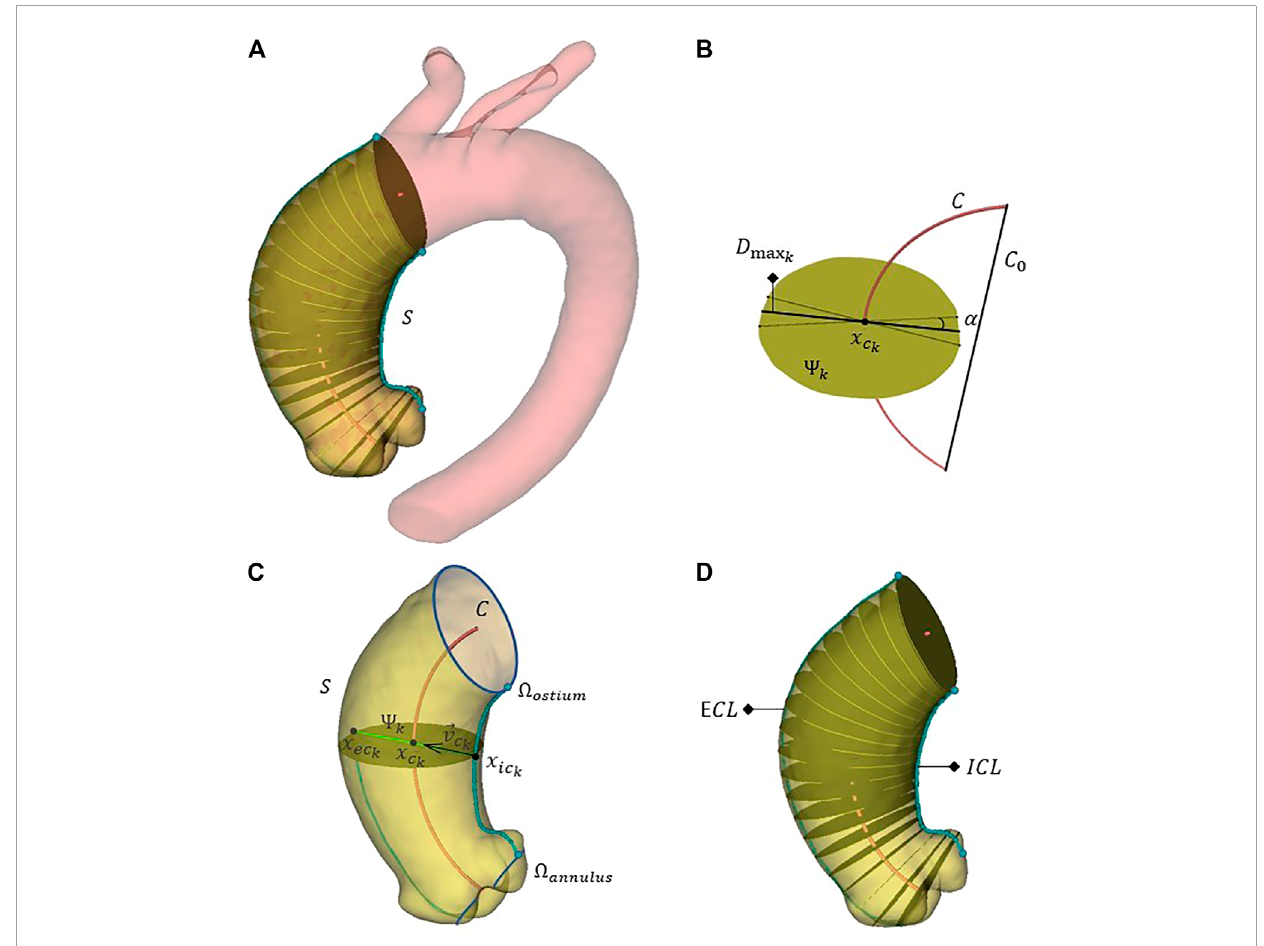
FIGURE 2 The full aorta segmentation, the discrete ascending aorta domain S and a subgroup of 20 aortic sections perpendicular to the centerline (A) . A generic section Ψ k isolated for the calculation of the related maximum diameter D max ; the centerline of the ascending section C and the segment C 0 are also k shown (B) . Identification of the point x ec to compute the external curvature line (C) . Isolated ascending section with the external and internal curvature k line ( ECL and ICL ) (D)